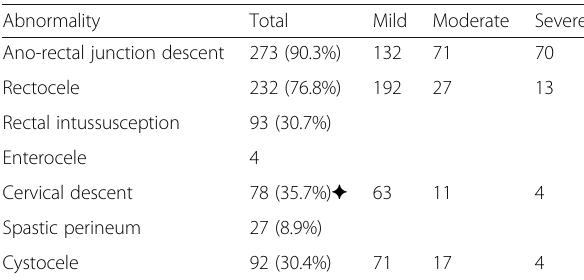
Table 2 Various pelvic floor abnormalities observed on magnetic resonance defecography